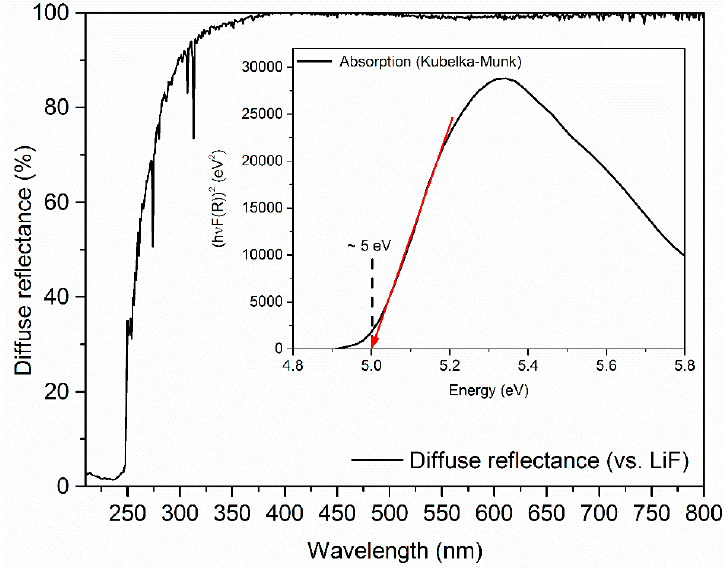
Figure 2. Tauc plot of Gd 3 Li 3 Te 2 O 12 derived from a diffuse reflectance measurement.